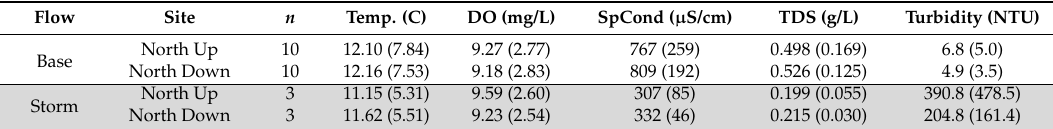
Table 7. Mean (1 SD) values of water quality parameters at the Haworth wetland restoration site for the 2017 sampling year. Storm flow data shown in gray